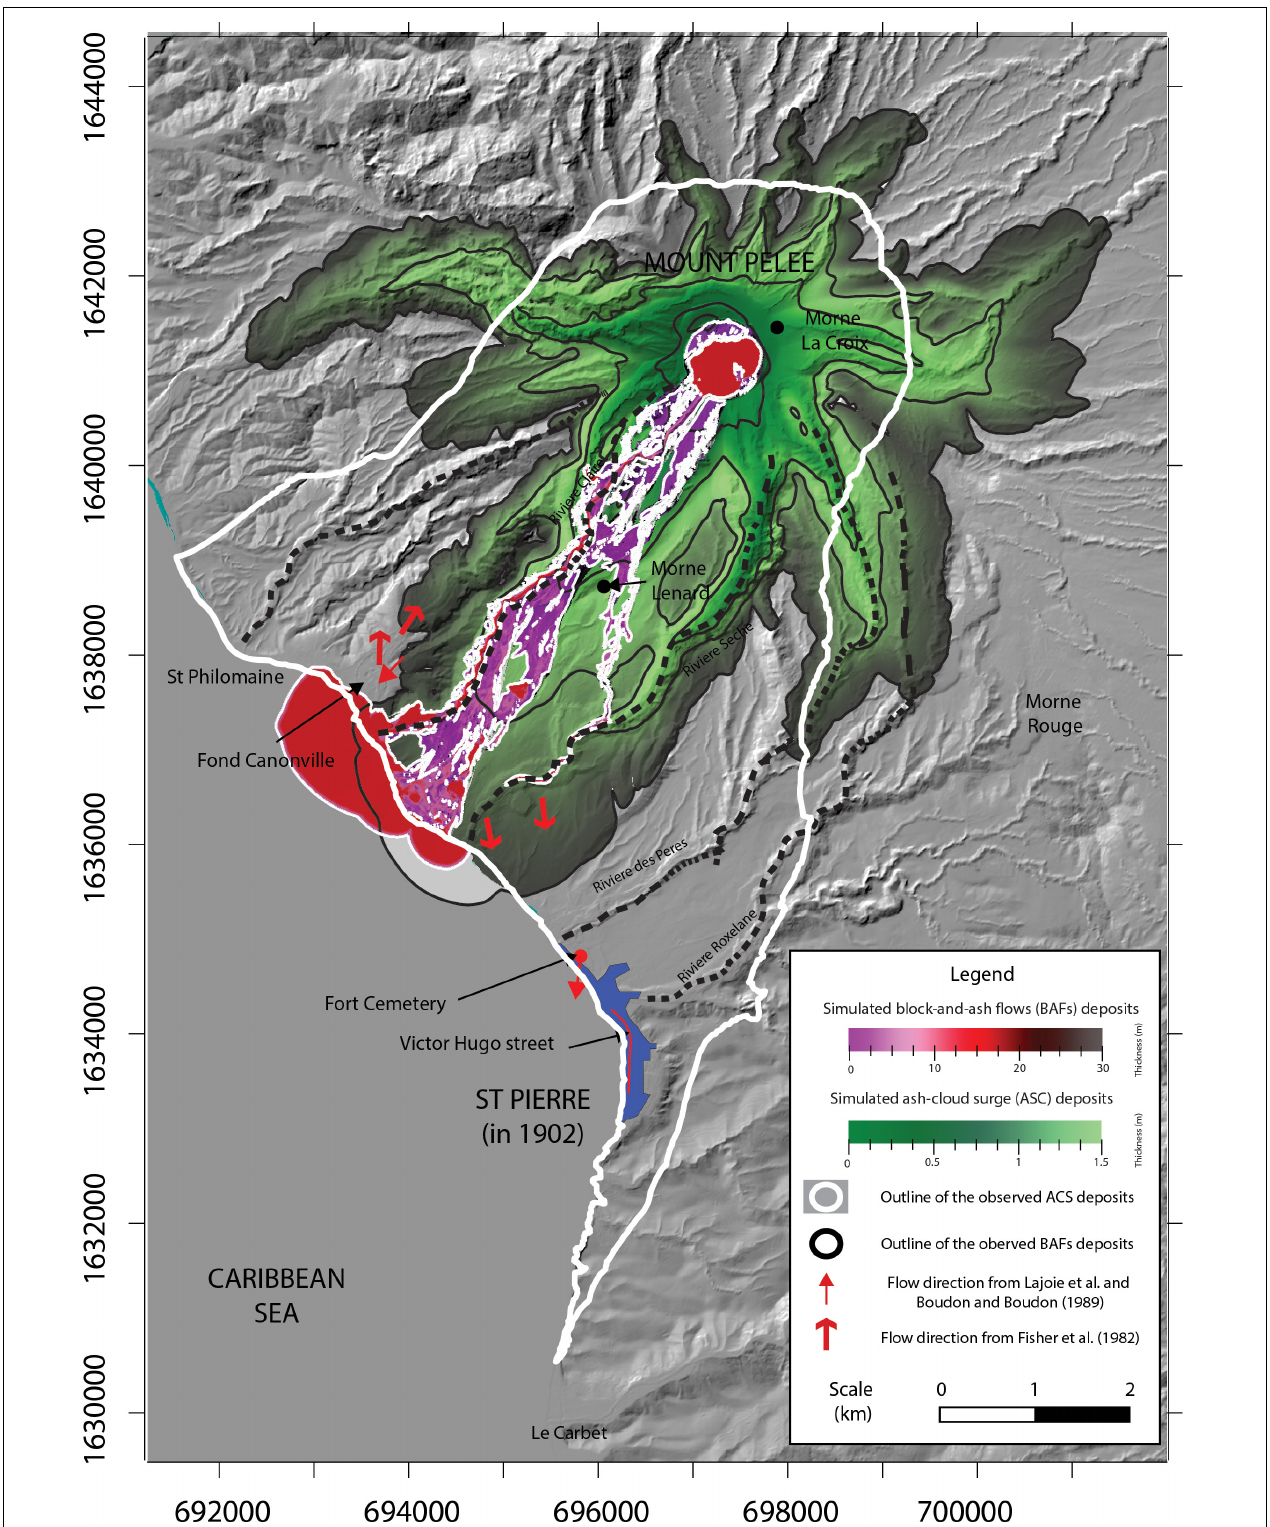
FIGURE 10 | Result of a complementary simulation with the ash-cloud surge and the block-and-ash flow supplied directly into the crater, without any surge production from the block-and-ash flow during the transport. The source conditions are adapted to supply 11.4 × 10 6 m 3 of ash-cloud surge and 20.8 × 10 6 m 3 of block-and-ash flow for the same duration (i.e., 200